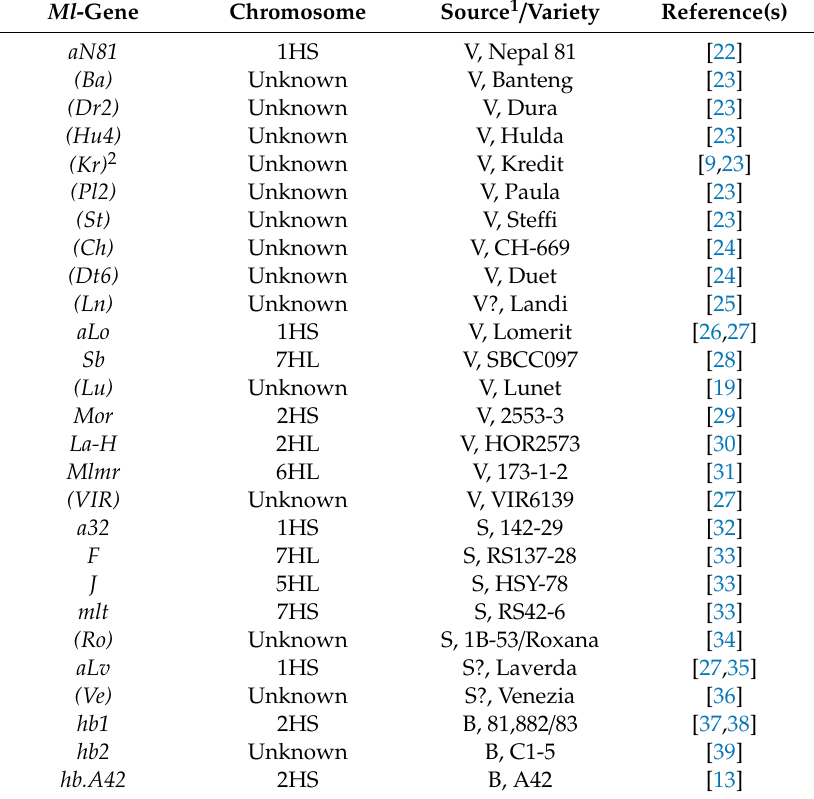
Table 2. Recently described resistance genes against barley powdery